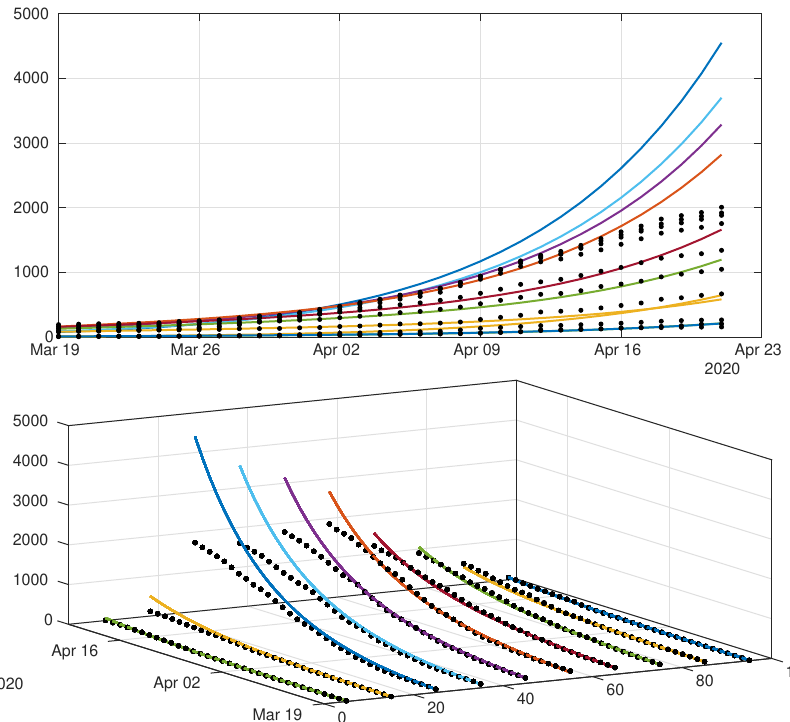
Figure A2. We plot a comparison between the model (12)–(15) (without public intervention) and the age structured data from Japan. We set 1/ ν = 1/ η = 7 days, f i which actually depends on the age class, with f 1 = 0.1, f 2 = 0.2, f 3 = 0.4, f 4 = 0.4, f 5 = 0.6, f 6 = 0.6, f 7 = 0.8, f 8 = 0.8, f 9 = 0.8, and f 10 =